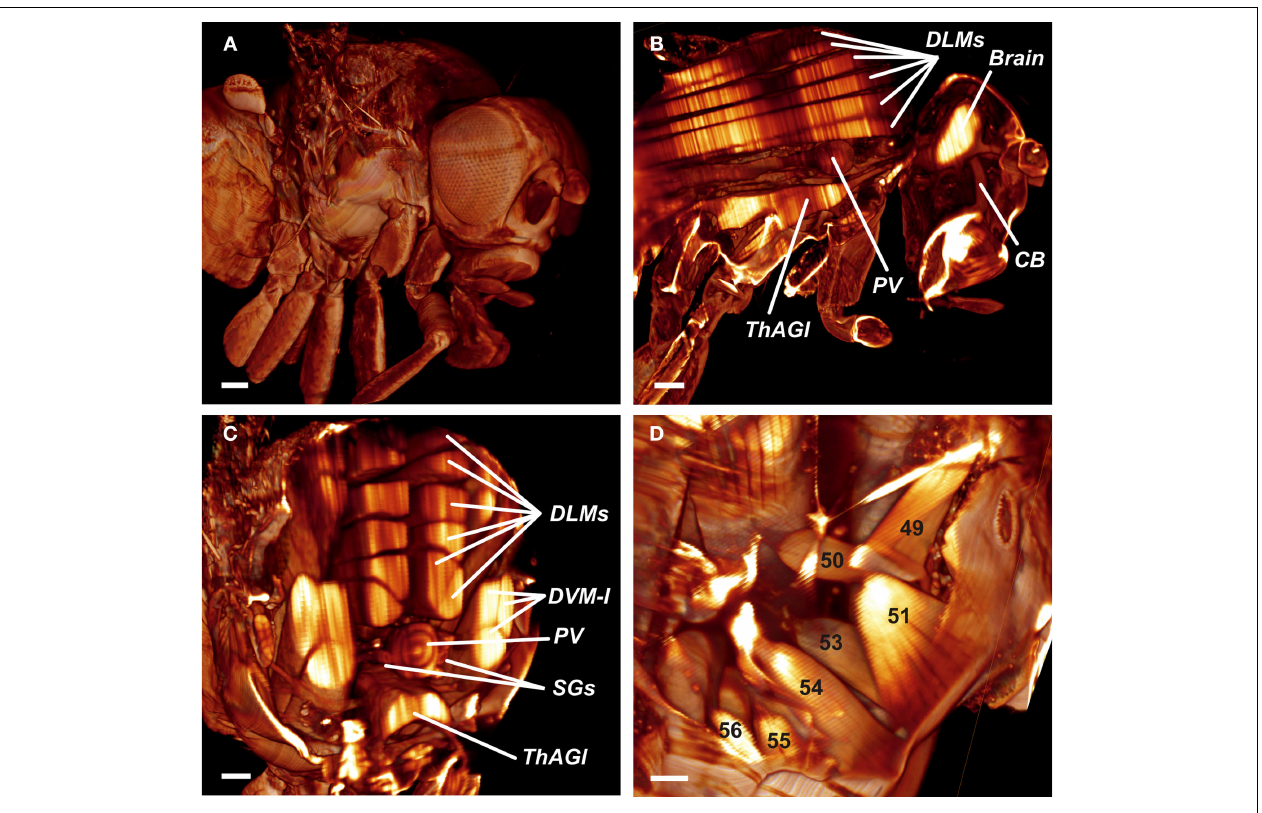
(C) Detail of the fl y virtually sectioned along a transversal plane through the thorax. DVM-I, dorsal–ventral muscles; SGs, salivary glands. Scale bar: 100 µm. (D) Detail showing the direct fl ight muscles DFM49–DFM56. DFM52 is only rudimentarily visible, because it is clipped by the viewing plane. Scale bar 40 µm.